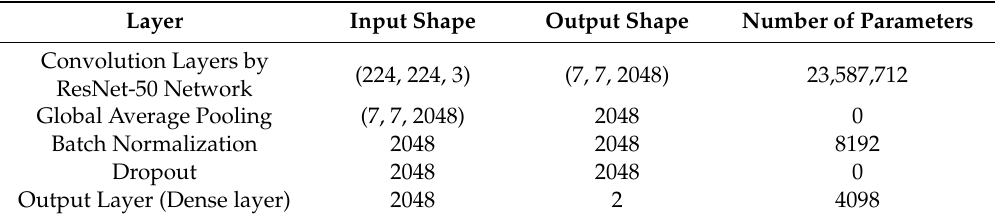
Table 2. ResNet50-based CNN architecture used in our experiments.